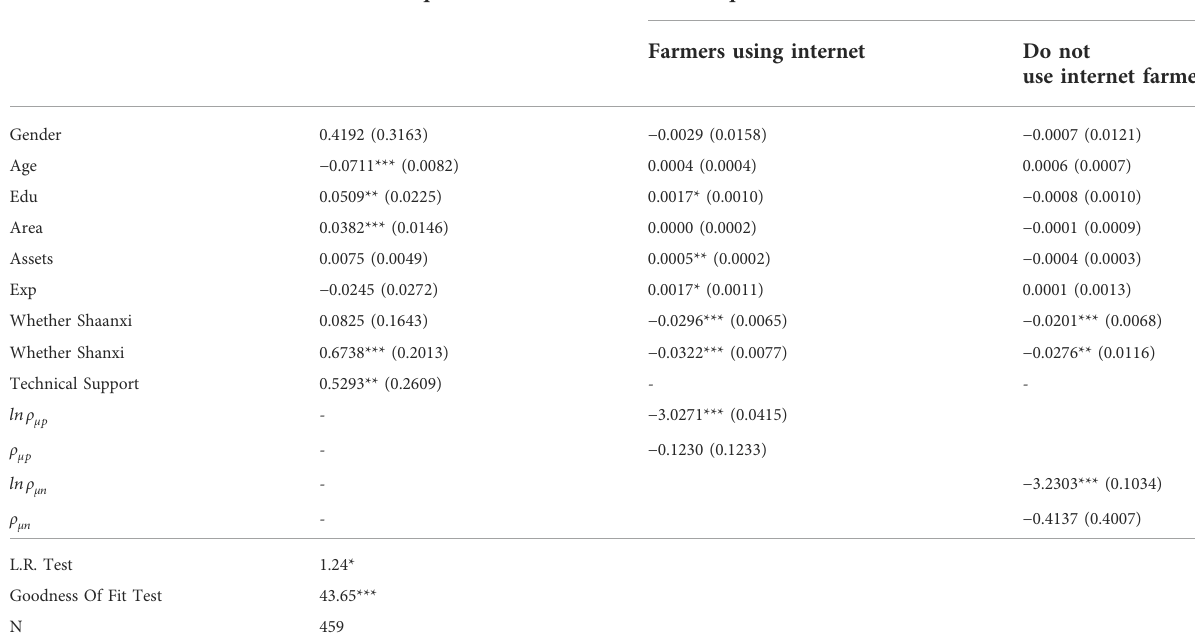
TABLE 3 The results of the simultaneous analysis using the internet and the impact model of agricultural green production ef fi ciency. Variable